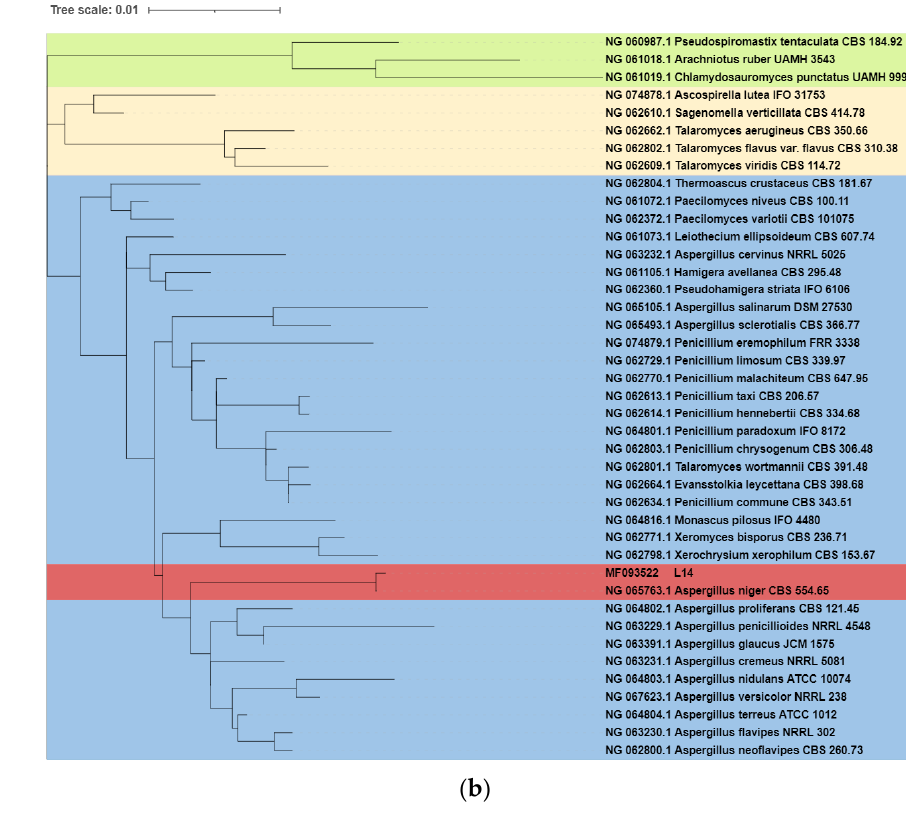
Figure 1. Colony morphology ( a ) and 18 S rRNA-based phylogenetic tree ( b ) of strain L14.